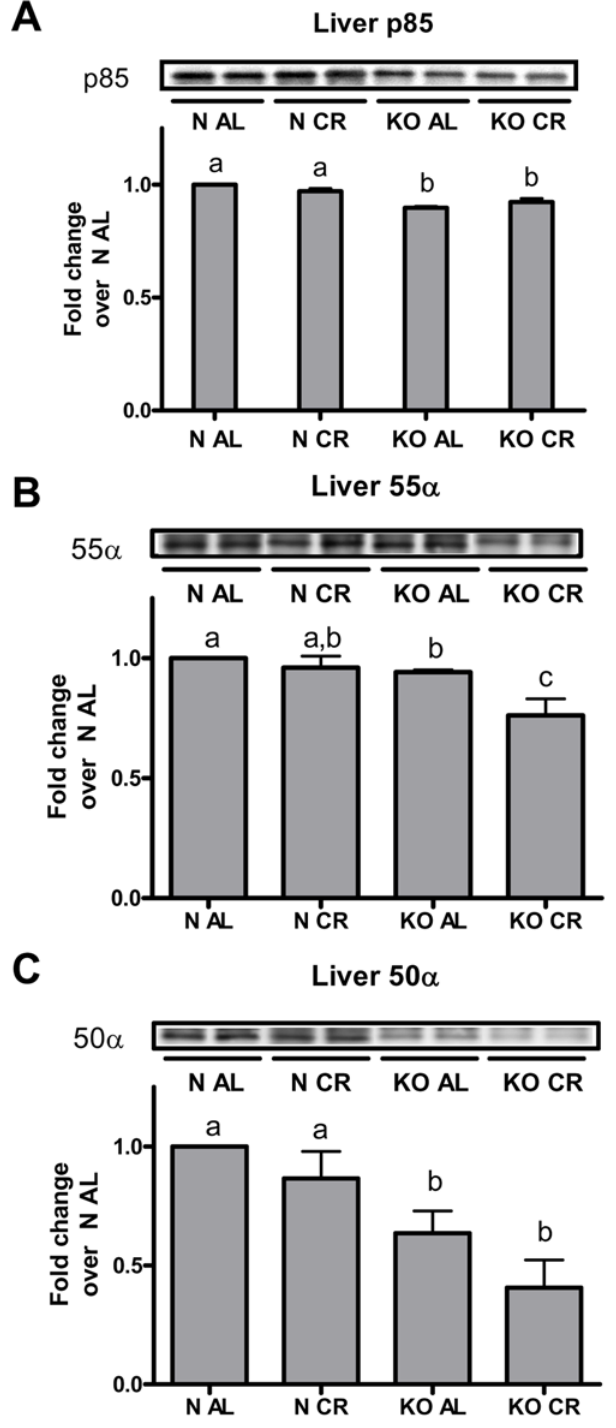
Figure 3. Liver PI3K subunit abundance in GHRKO (KO) and normal (N) mice fed adlibitum (AL) or 30% calorie restriction (CR) for one year. Liver protein isolates were immunoprecipitated (IP) with anti-pan-p85. Total p85 a (A), 55 a (B) and 50 a (C) subunits were separated using SDS-PAGE, transferred to nitrocellulose membranes and blotted with anti-pan-p85. Bands are representative blots from 4–6 male mice per phenotype/diet/treatment group. Values with unlike superscripts/letters are significantly different (P , 0.05).